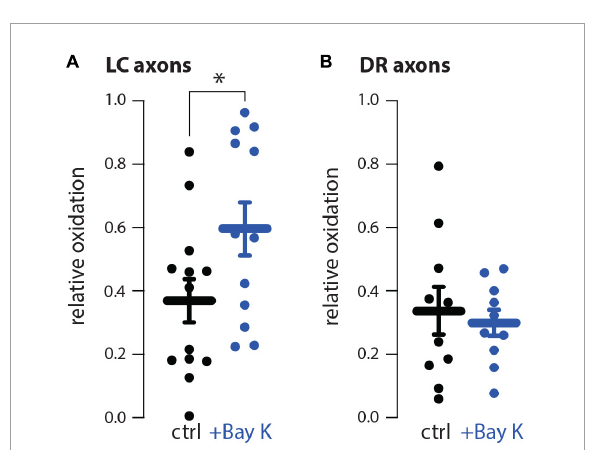
FIGURE5 The L-type Ca 2 + channel activator Bay K8644 increased mitochondrial oxidant stress in locus coeruleus (LC) but not dorsal raphe (DR) axons. (A) Compared to aCSF perfusion (ctrl), L-type Ca 2 + channel activation using 10 µ M Bay K8644 (+Bay K) increased mitochondrial oxidant stress in LC axons; ctrl n = 13 brain slices/4 mice, +Bay K n = 12 brain slices/4 mice. Data analyzed using an unpaired t -test [ t ( 23 ) = 2.119, p = 0.0451, two-tailed]. (B) +Bay K did not increase DR axonal mitochondrial oxidant stress; ctrl n = 10 brain slices/4 mice, +Bay K n = 10 brain slices/4 mice. Data analyzed by unpaired t -test [ t ( 18 ) = 2.119, p = 0.4312, two-tailed]; ∗ p <